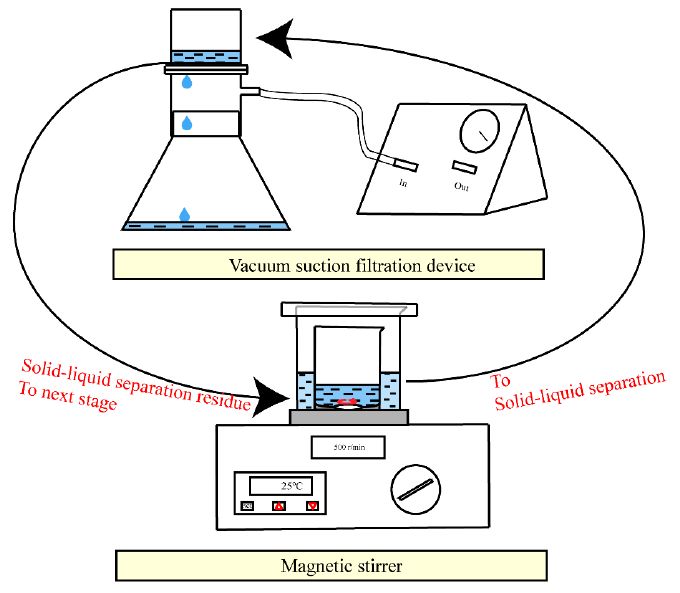
Figure 3. Experimental devices.